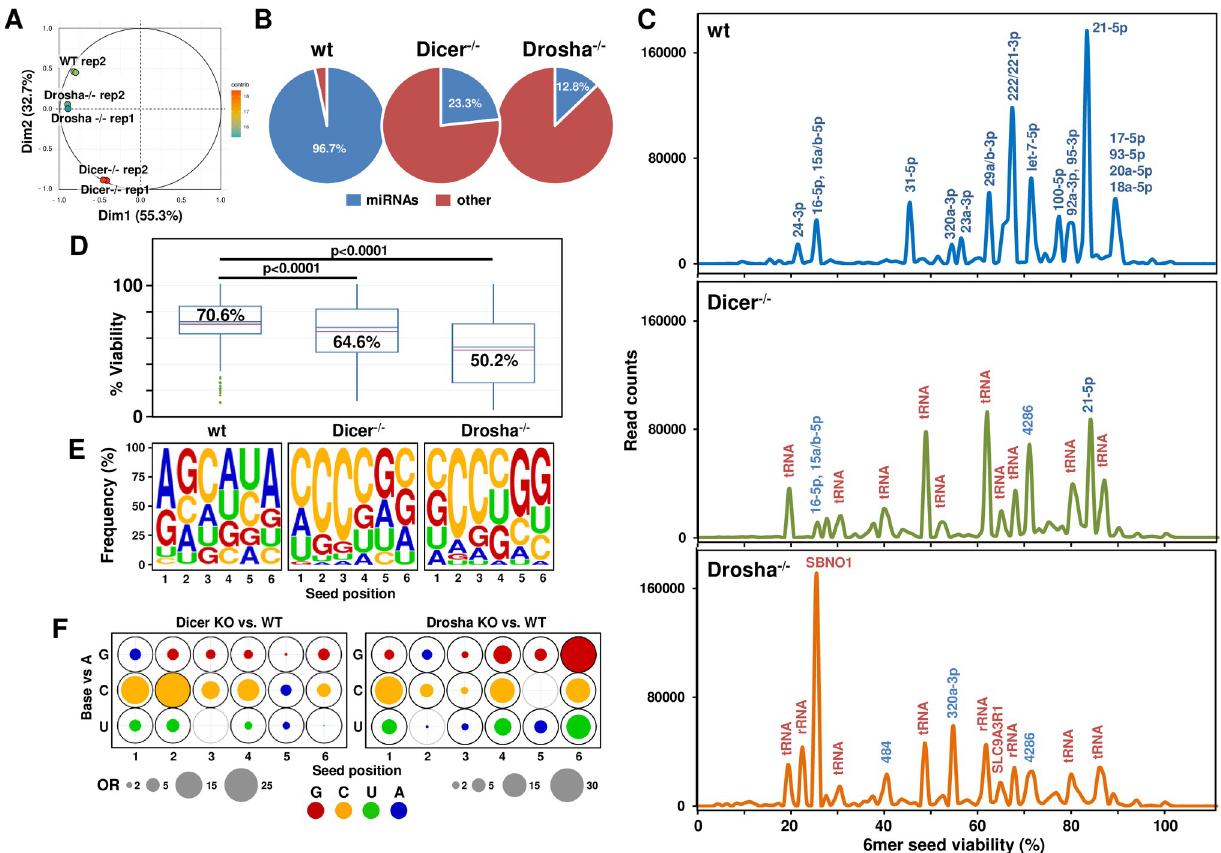
Fig 2. The RISC in HCT116 Dicer and Drosha k.o. cells is enriched in sRNAs with toxic 6mer seeds compared to wt cells. (A) Principal component analysis (PCA) plot illustrating the differences in RISC composition of Dicer and Drosha k.o. cells compared to HCT116 wt cells, and the reproducibility of technical and biological replicates. The x-axis represents dimension 1 (dim1) and explains 55.3% of the variance, while the y-axis represents dimension 2 (dim2) and explains 32.7% of the variance. Each cell type was analyzed as two biological replicates. Each spot represents a single replicate sample from each cell type. Green- HCT116 wt, blue- Drosha k.o. and red- Dicer k.o. (B) Pie charts showing RISC composition of HCT116 wt, Dicer and Drosha k.o. cells. Abundance of miRNAs is shown in blue and all other sRNAs in red. (C) RISC-bound sRNA Seed Tox graphs of HCT116 wt, Dicer k.o., and Drosha k.o. cells. When a peak is labeled with multiple miRNAs (blue), the most abundant one is listed first. RNAs are only labeled if they account for 1000 reads or more. miRNAs are labeled in blue, other sRNAs in red. (D) Average predicted 6mer seed toxicity of all RISC-bound sRNAs enriched in cells in C. p values were calculated using a Wilcoxon rank test. (E) Seed composition of all RISC-bound sRNAs enriched in cells in C. (F) Positional changes in the 6mer seed composition between genotypes. Filled circles at each position represent the odds ratio (OR) estimates comparing the odds of observing G, C and U vs. A between genotypes, based on the multinomial mixed effects model. A was set as the reference because A-rich 6mer seeds were the least toxic [16]. The outer circle corresponds to the largest observed OR for each pairwise genotype comparison (e.g., Dicer k.o. vs. wt), with bold black circles denoting statistical significance based on p-values adjusted using Tukey’s method. OR < 1 estimates are represented with blue circles with area OR � = 1/ OR, indicating that A is more likely in this position. Circle area is scaled to be proportional to the OR. end of the 6mer seed as reported [17]. The outcome variable in the model is the nucleotide in each position of each seed. We assume that at each position nucleotides follow a multinomial distribution with 4 possible outcomes (A, C, G, U), and, as in logistic regression, we must set one of the levels as the reference (we set A as the reference because A-rich 6mer seeds were the least toxic [16]). Group (e.g., genotype or experimental condition), position and their interac- tion are included as the "fixed effect" predictors, and the seed itself (i.e., the seed id) is included as the “random effect”. We note that a unique id is assigned to the seed within each read, rather than to each unique 6mer sequence, thus accounting for seed abundance by including a dis- tinct “subject” for each observed sRNA read. For example, if two distinct sRNA’s with the same 6mer seed occur 50 and 100 times each, respectively, the model will include 150